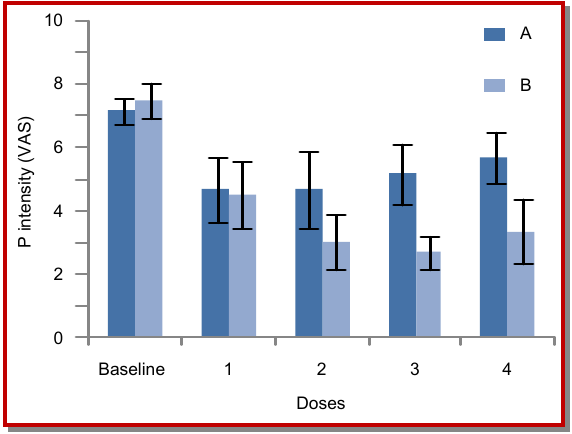
Figure 3: Differences in pain intensity after administration of solution prepared by sustained release tablets with and with- out added preservatives in a day x: solutions prepared without added preservative; y: solutions prepared with added preservative